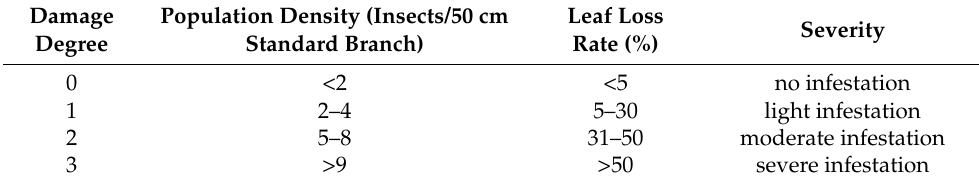
Table 1. The classification of the severity of insect